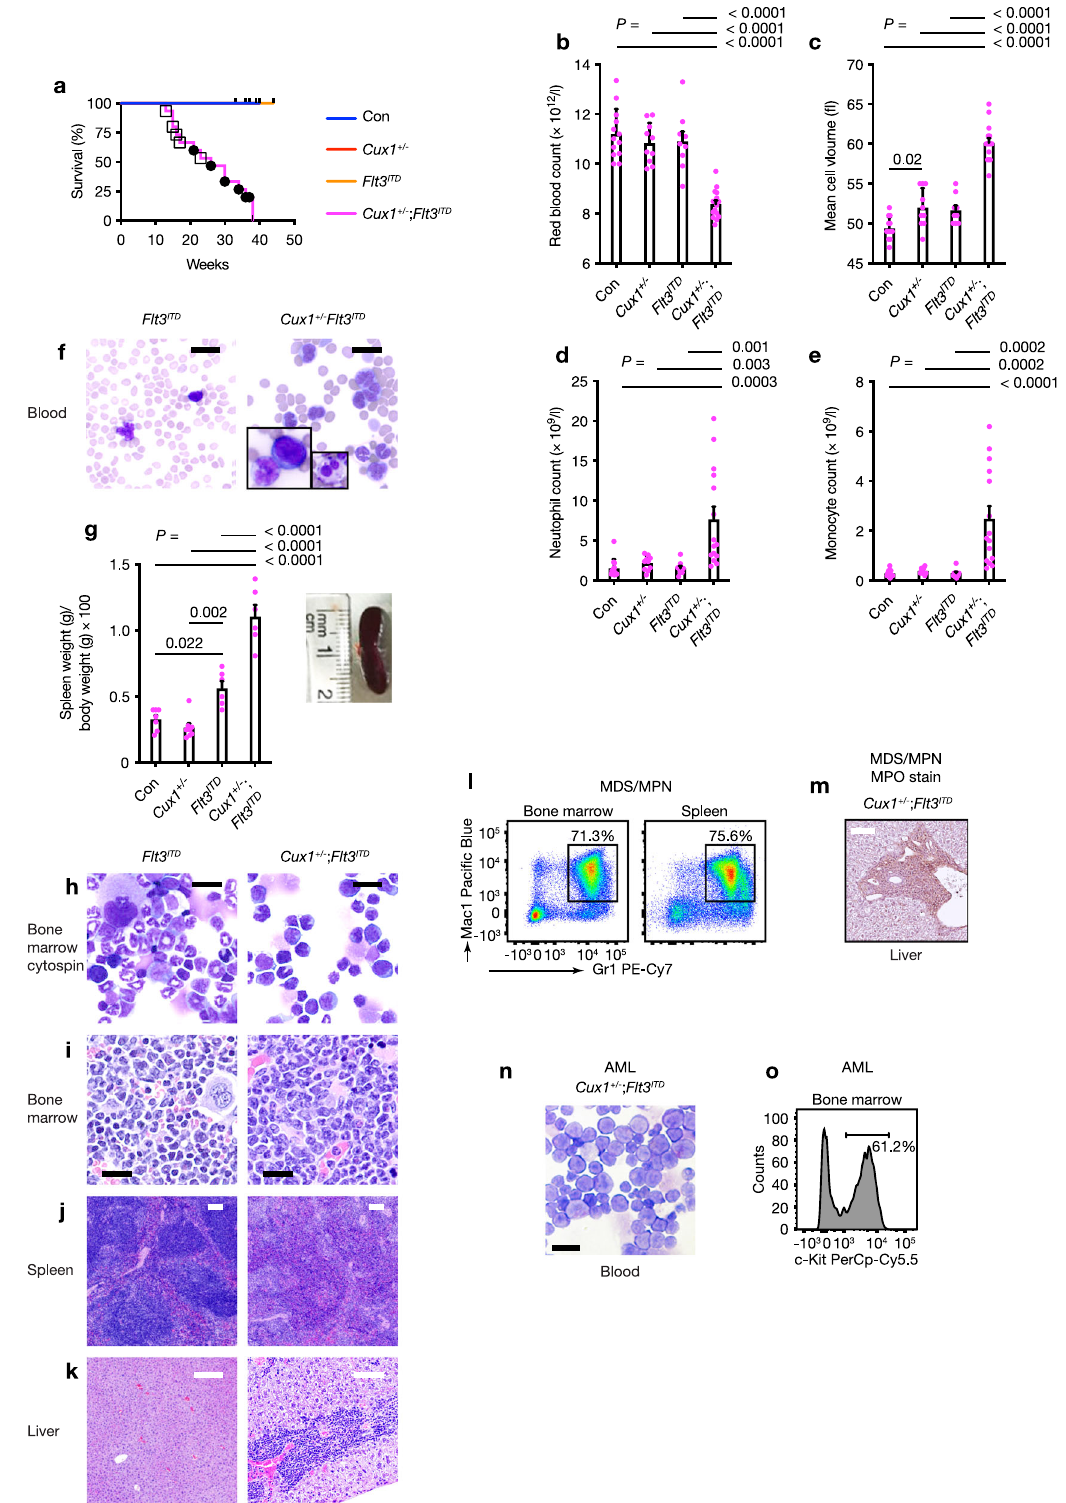
form of caspase-3 (C3). Using this approach, we con fi rmed a reduction in early- (C3 + ) and late- (C3 + FVD + ) apoptotic cells in LSK cells from Cux1 + / − ; Flt3 ITD mice consistent with our Annexin-V data, which we attributed to the MPP subcompart- ment (Supplementary Fig 4). The frequency of early-apoptotic cells was also lower in LK cells, and in particular GMPs, from Cux1 + / − ; Flt3 ITD mice, although the changes appeared to be